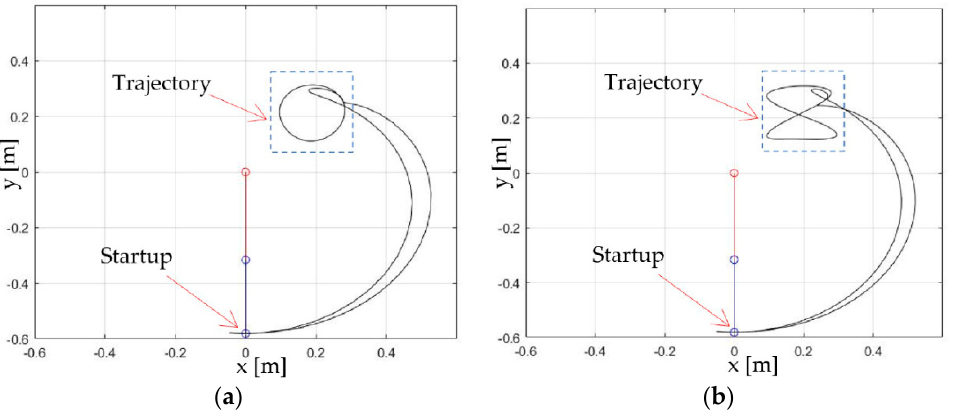
Figure 5. Simulation of the trajectories by implementing the PD-DGD-type control algorithm with compensation of the desired gravity: ( a ) circle, ( b ) lemniscate.